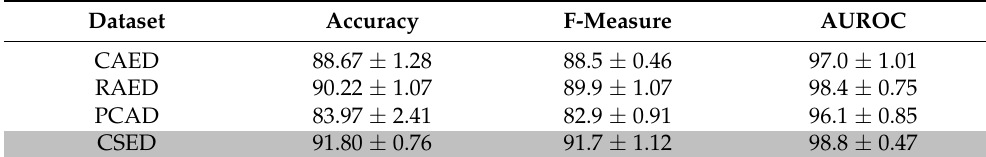
Table 7. Performance of RF (multi-class